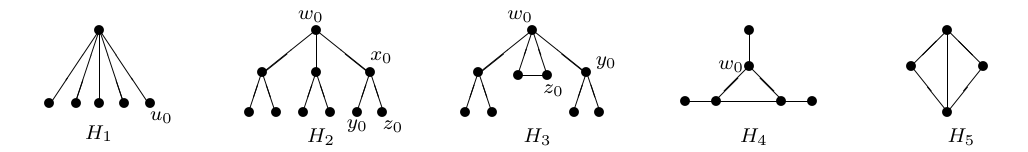
Fig.1. The 3-cutwidth critical graphs Figure 1. The 3-cutwidth critical